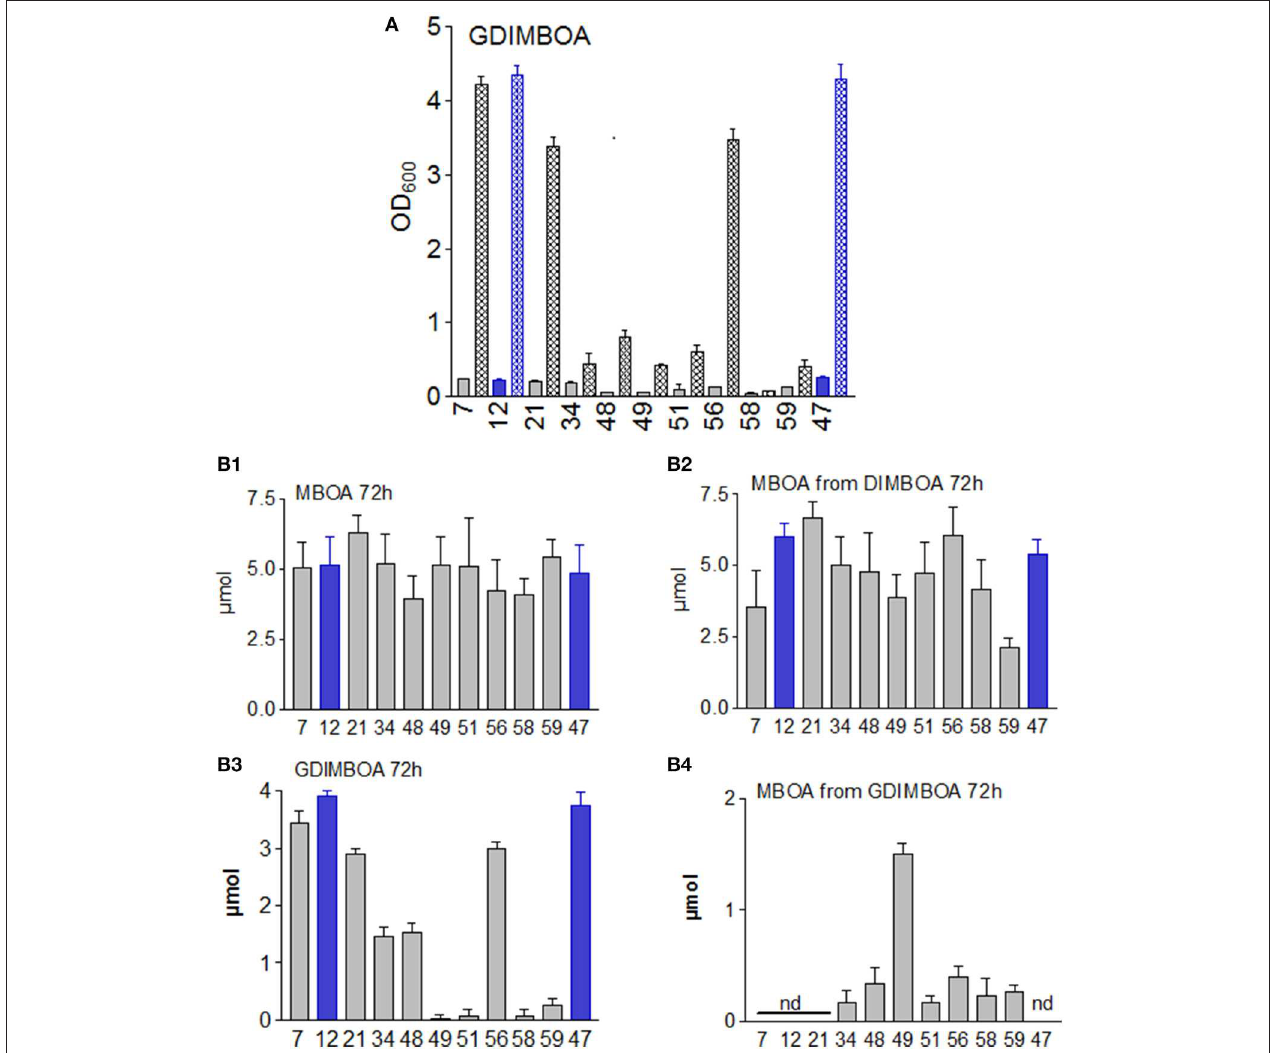
FIGURE 4 | (A) Growth of the microorganisms in presence of 5 µ mol GDIMBOA. (B1) Amounts of MBOA in culture media after 72h of incubation with 7.5 µ mol 6 . (B2) Amounts of MBOA in the culture media after 72h of incubation with 7.5 µ mol DIMBOA. (B3) Amounts of DIMBOA after 72h of incubation with 5 µ mol 2 in media containing gluconate. (B4) Amounts of MBOA in gluconate containing media after 72h of incubation with 2 . n = 4. Nd, not detectable. Microorganisms: Mycobacterium fortuitum (7), Bacillus aryabhattai (34), Bacillus cereus (59), Bacillus megaterium (21, 48), Bacillus methylotrophicus (58), Lysinibacillus xylanilyticus (56), Paenibacillus polymyxa (51), Aminobacter aminovorans (49), the fungi Papulaspora sepedonioides (12), and Trichoderma viride (47) . Blue bars, fungi; gray bars, bacteria. OD 600 culture start, ; OD 600 after 72h,